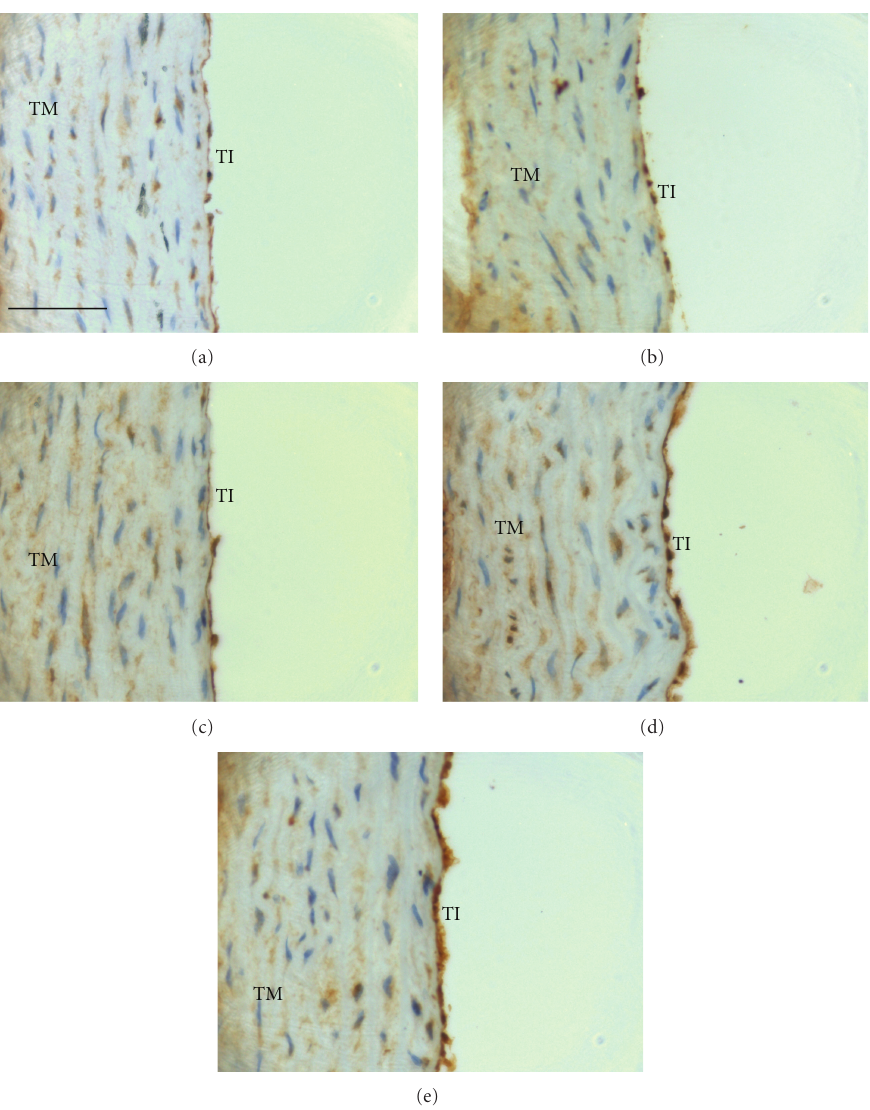
Figure 4: Photomicrographs of aortic sections showing immunostaining for VCAM-1. Groups are as follows: (a) control rats; rats fed (b) fresh (FPO), (c) one-time-heated (1HPO), (d) five-time-heated (5HPO), or (e) ten-time-heated palm oil (10HPO). Aortic sections from rats fed 5HPO and 10HPO showed an intense staining of VCAM-1 on the tunica intima [(d) and (e)]. In contrast, aortic sections from rats fed FPO and 1HPO showed relatively little staining of VCAM-1 [(b) and (c)] compared to control (a). TI: tunica intima; TM: tunica media. Same magnification is applied to all pictures ( × 400). Calibration bar = 50 μ